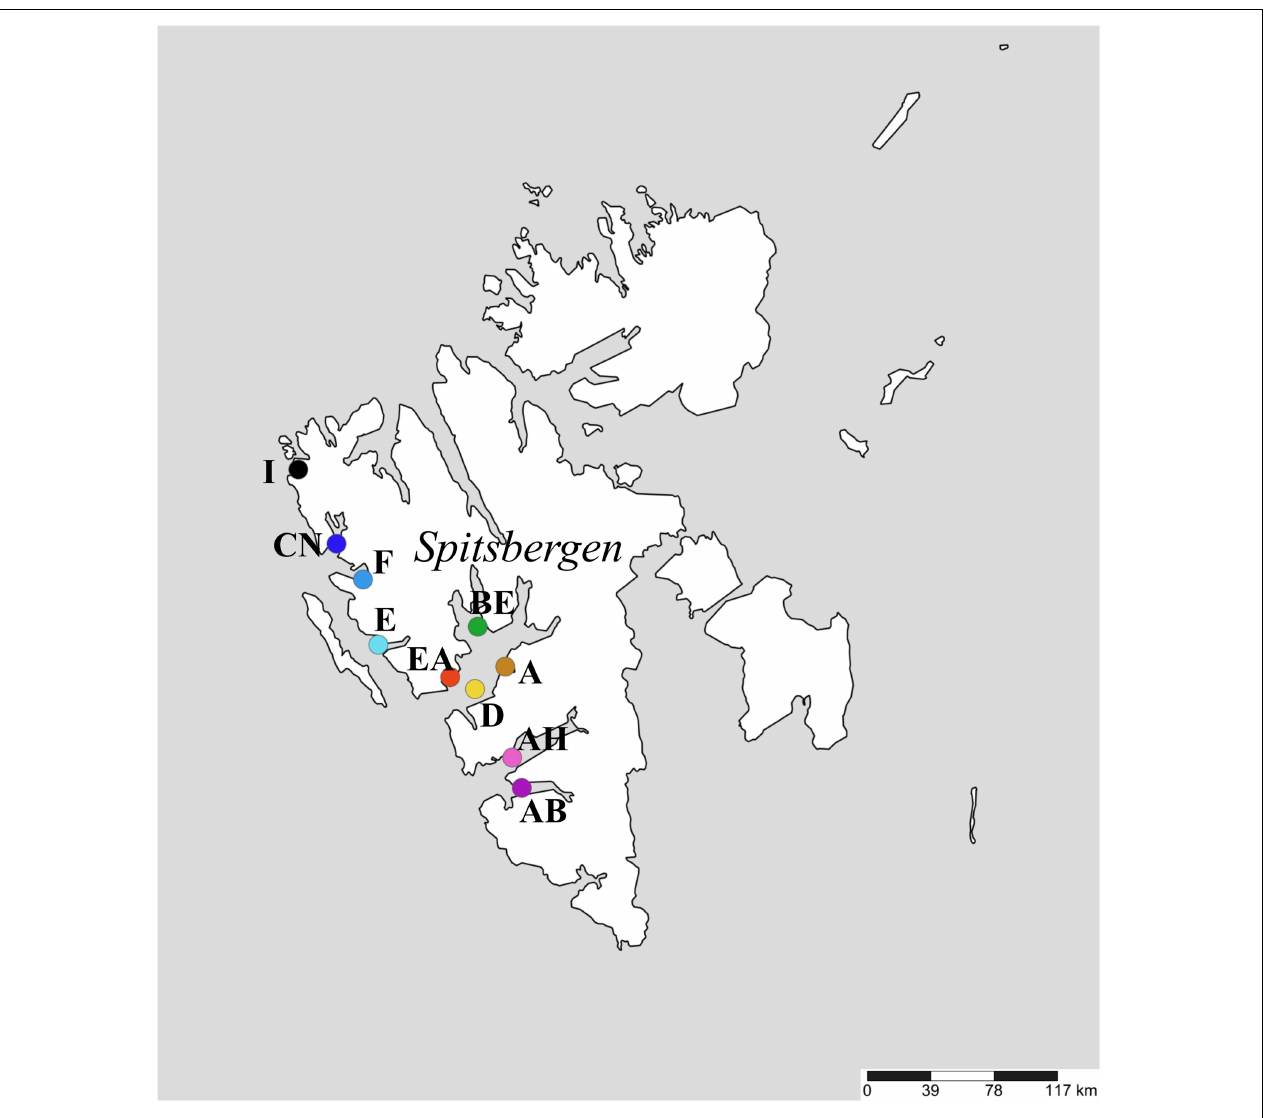
FIGURE 1 | Map showing the ten sediment sampling stations along the west coast of Spitsbergen, Svalbard.